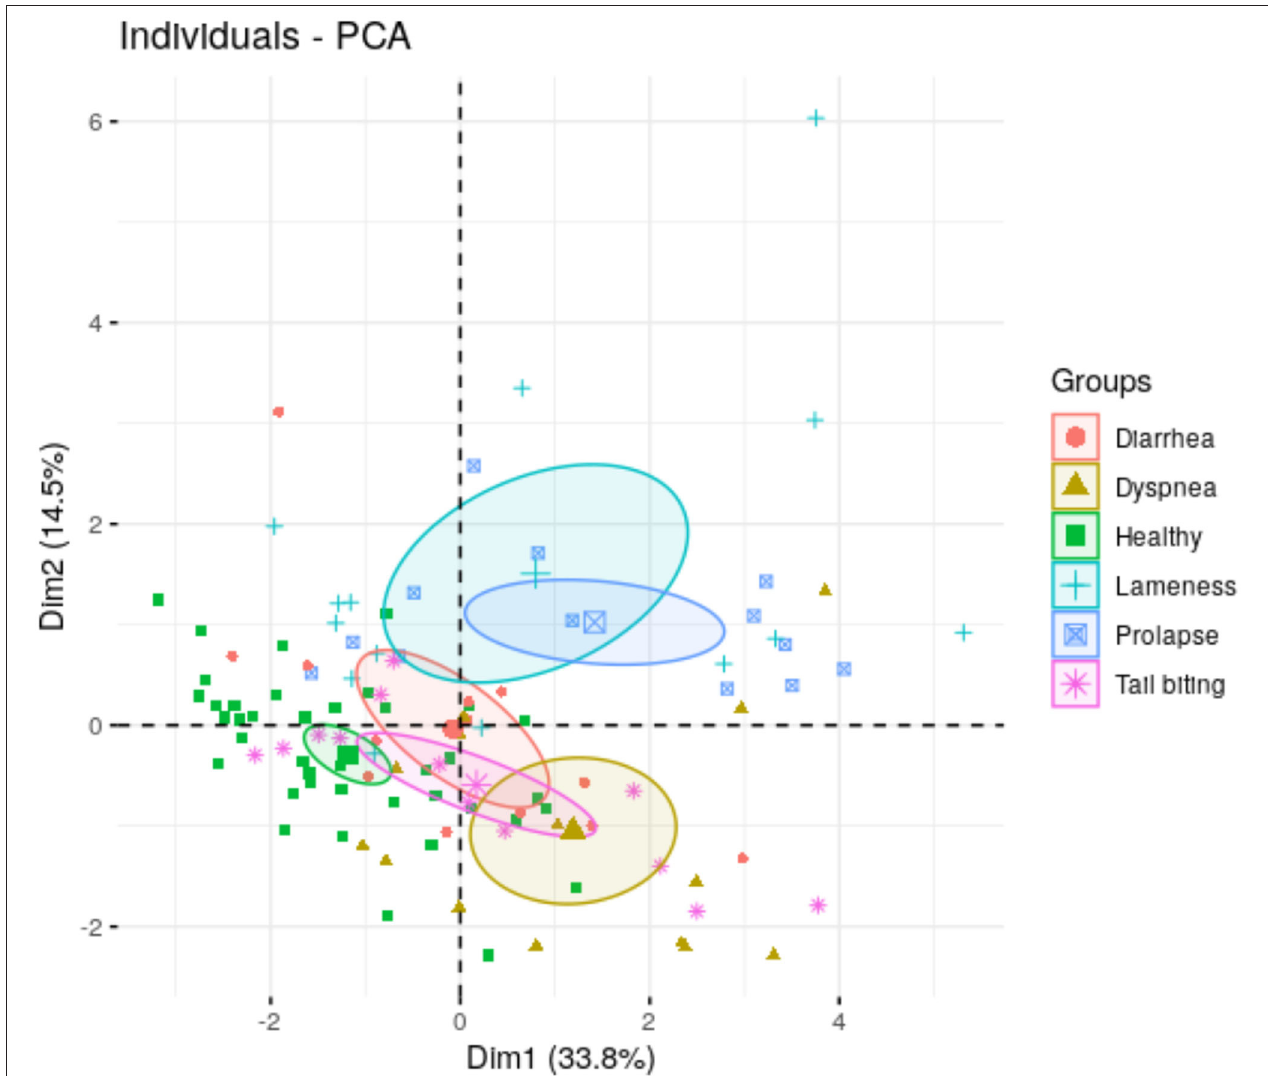
FIGURE 2 | Principal components 1 (Dim 1) and 2 (Dim 2) of salivary biomarkers data form animals under different health conditions (healthy, rectal prolapse, tail-biting lesions, diarrhea, lameness, or dyspnea). In brackets, the percentage of total variance explained the principal